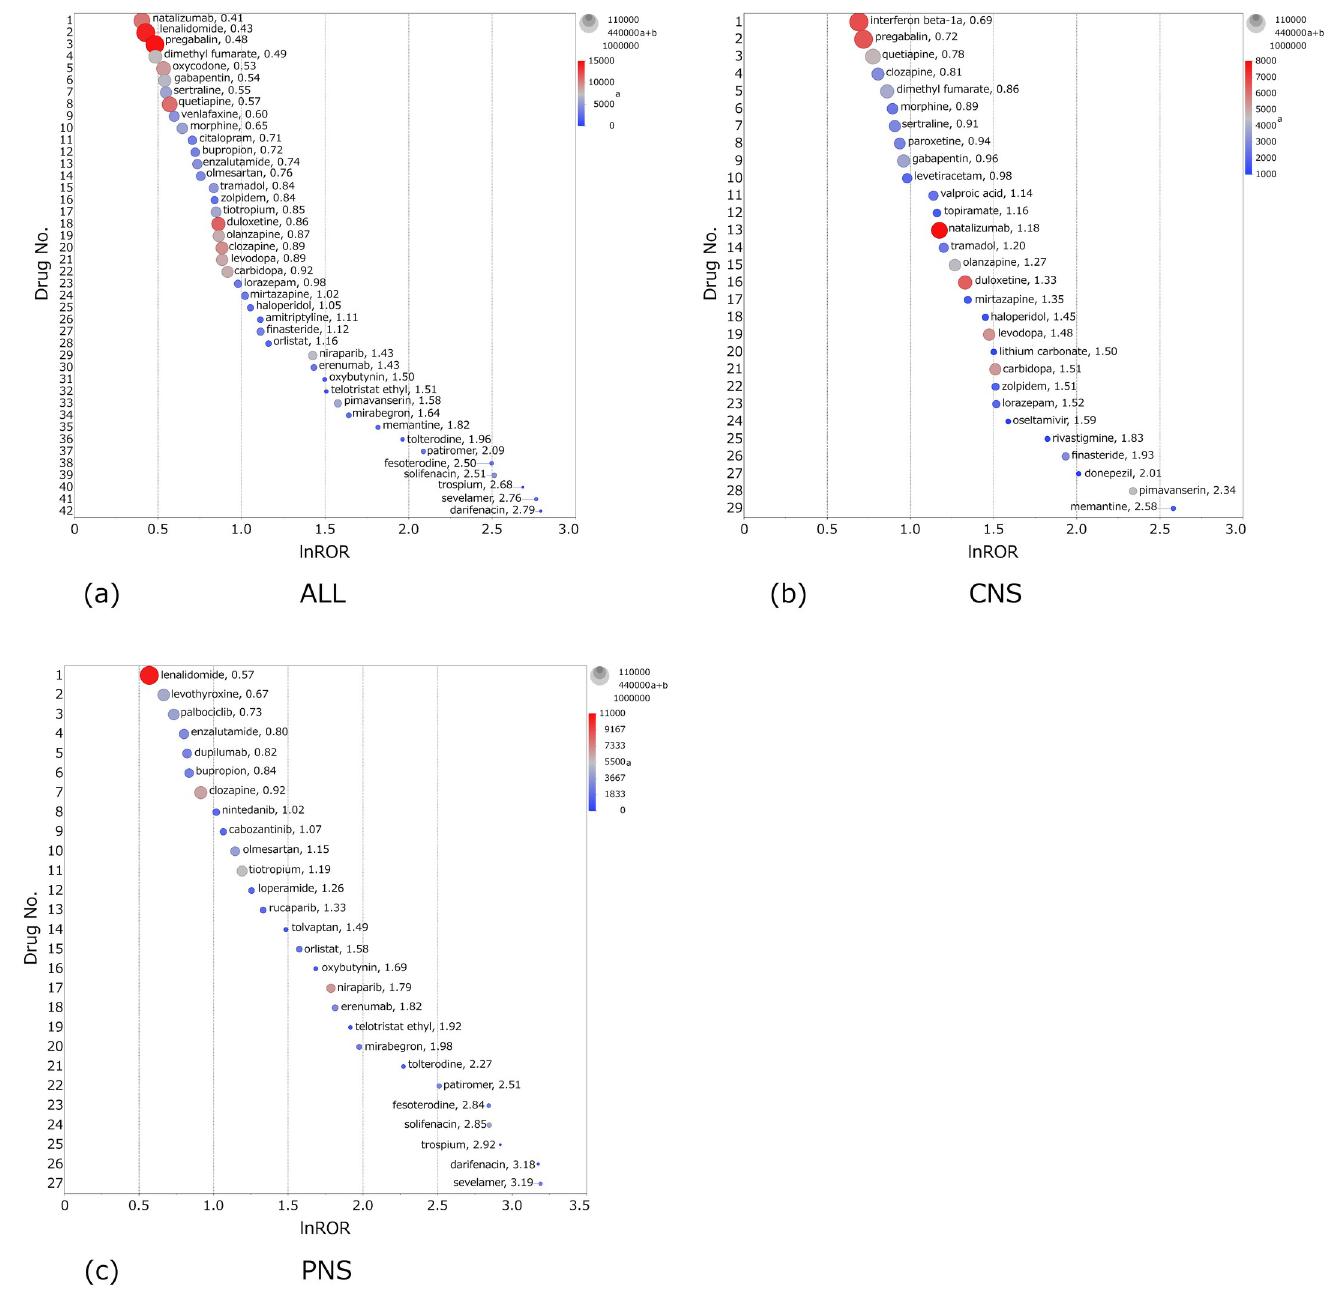
Fig 5. Plots of drugs whose − log P is 308. Drugs whose − log P is 308 and lnRORs are greater than 0 in FAERS: (a) ALL, (b) CNS, and (c) PNS. The size of the dots reflects the number of cases of each drug: It is “a+b” in the two–by–two contingency table. The color of the dots indicates the number of cases of anticholinergic AEs of the drug: It is “a” in the two–by–two table. Each dot is a drug, and the abscissa is the lnROR axis. The ordinate axis is the drug number by the descending